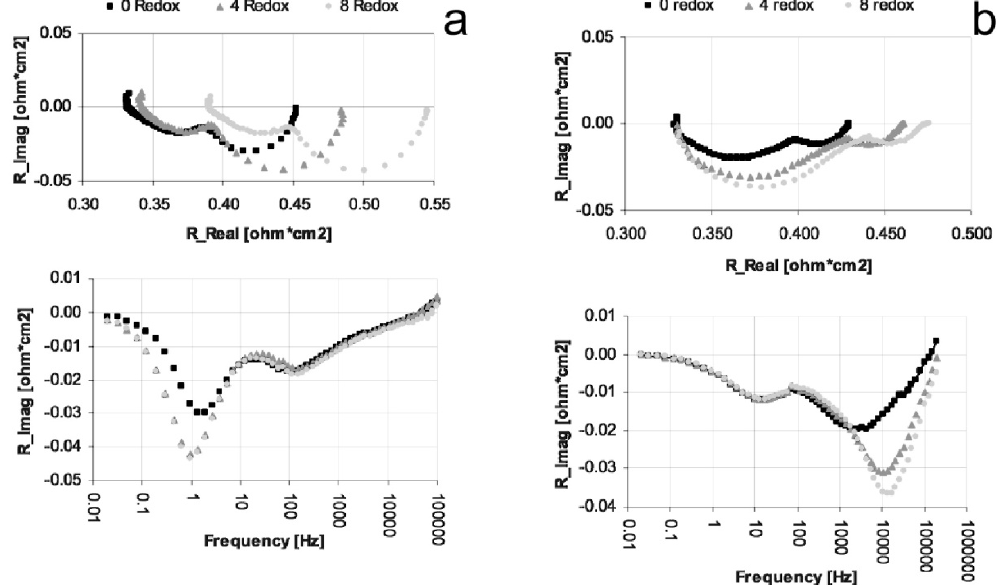
Figure 21. Impedance spectra at OCV during RedOx cycling at 950 °C of ( a ) Ni-40CGO (Ce Gd O ) and ( b ) Ni-8YSZ anodes with a 8YSZ electrolyte support. Top: Nyquist 0.6 0.4 2 − d plot; bottom: complex impedance plot